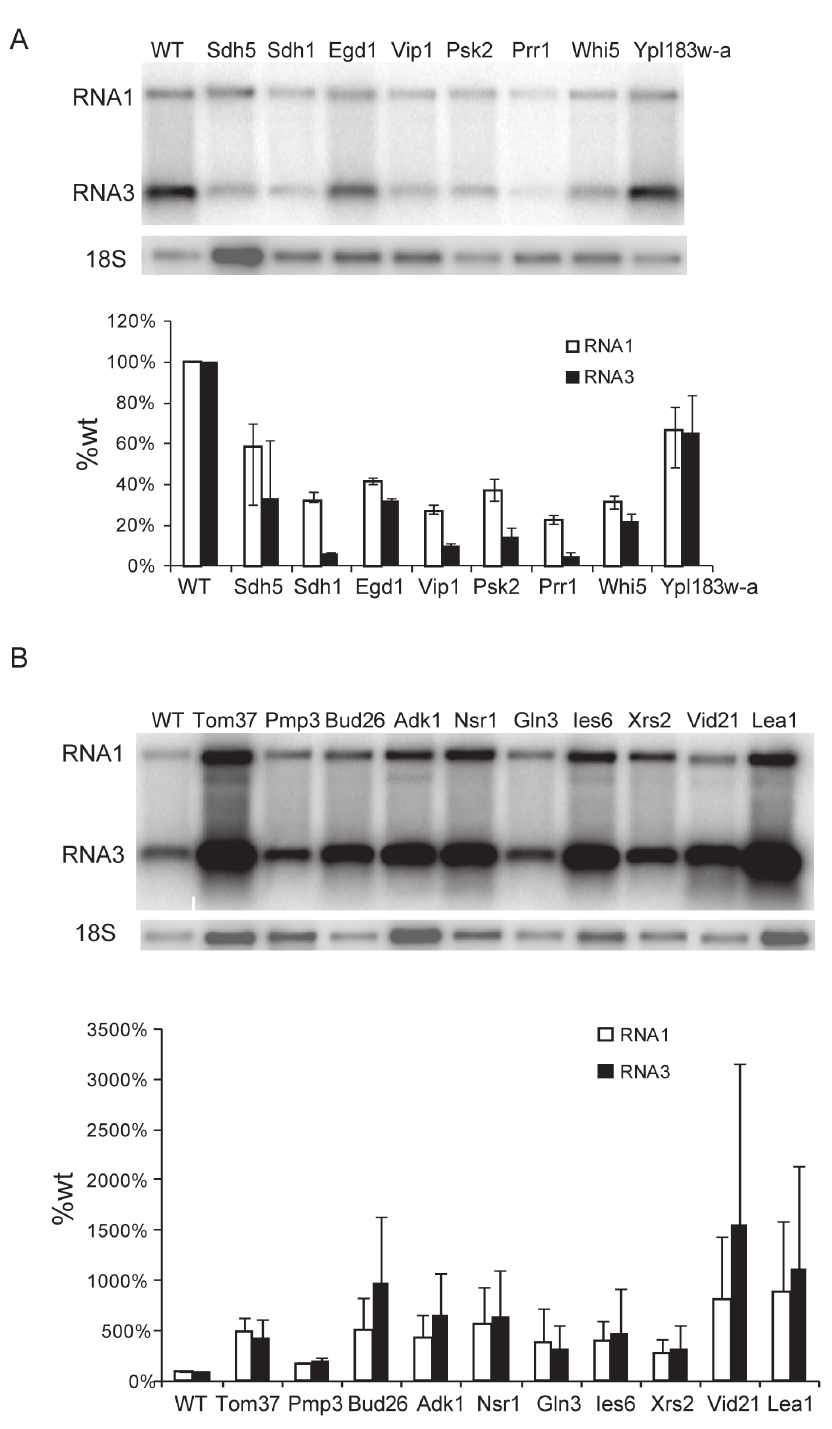
Figure 3. FHV RNA1 replication in selected yeast deletion mutants. Yeast strains with the indicated gene deletions were transformed with plasmid pF1 (Figure 1A) and, following galactose-induction of pF1 transcription, FHV genomic RNA1 replication and subgenomic RNA3 production were assayed by Northern blot hybridization. The histograms show the averages and standard deviations of RNA1 and RNA3 levels across four independent experiments. Representative Northern blots are shown above each histogram. A). FHV wild type RNA1 replication in all 8 deletion mutants whose deleted gene functions facilitate FHV replication. WT denotes the no deletion control. B). FHV wild type RNA1 replication in a selected subsets of yeast deletion mutants whose deleted gene functions normally inhibit FHV replication. Accordingly, these strains show increased FHV replication.